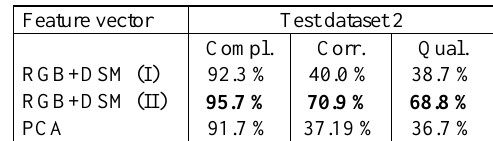
Table 2. Quantitative evaluation results for test dataset 1